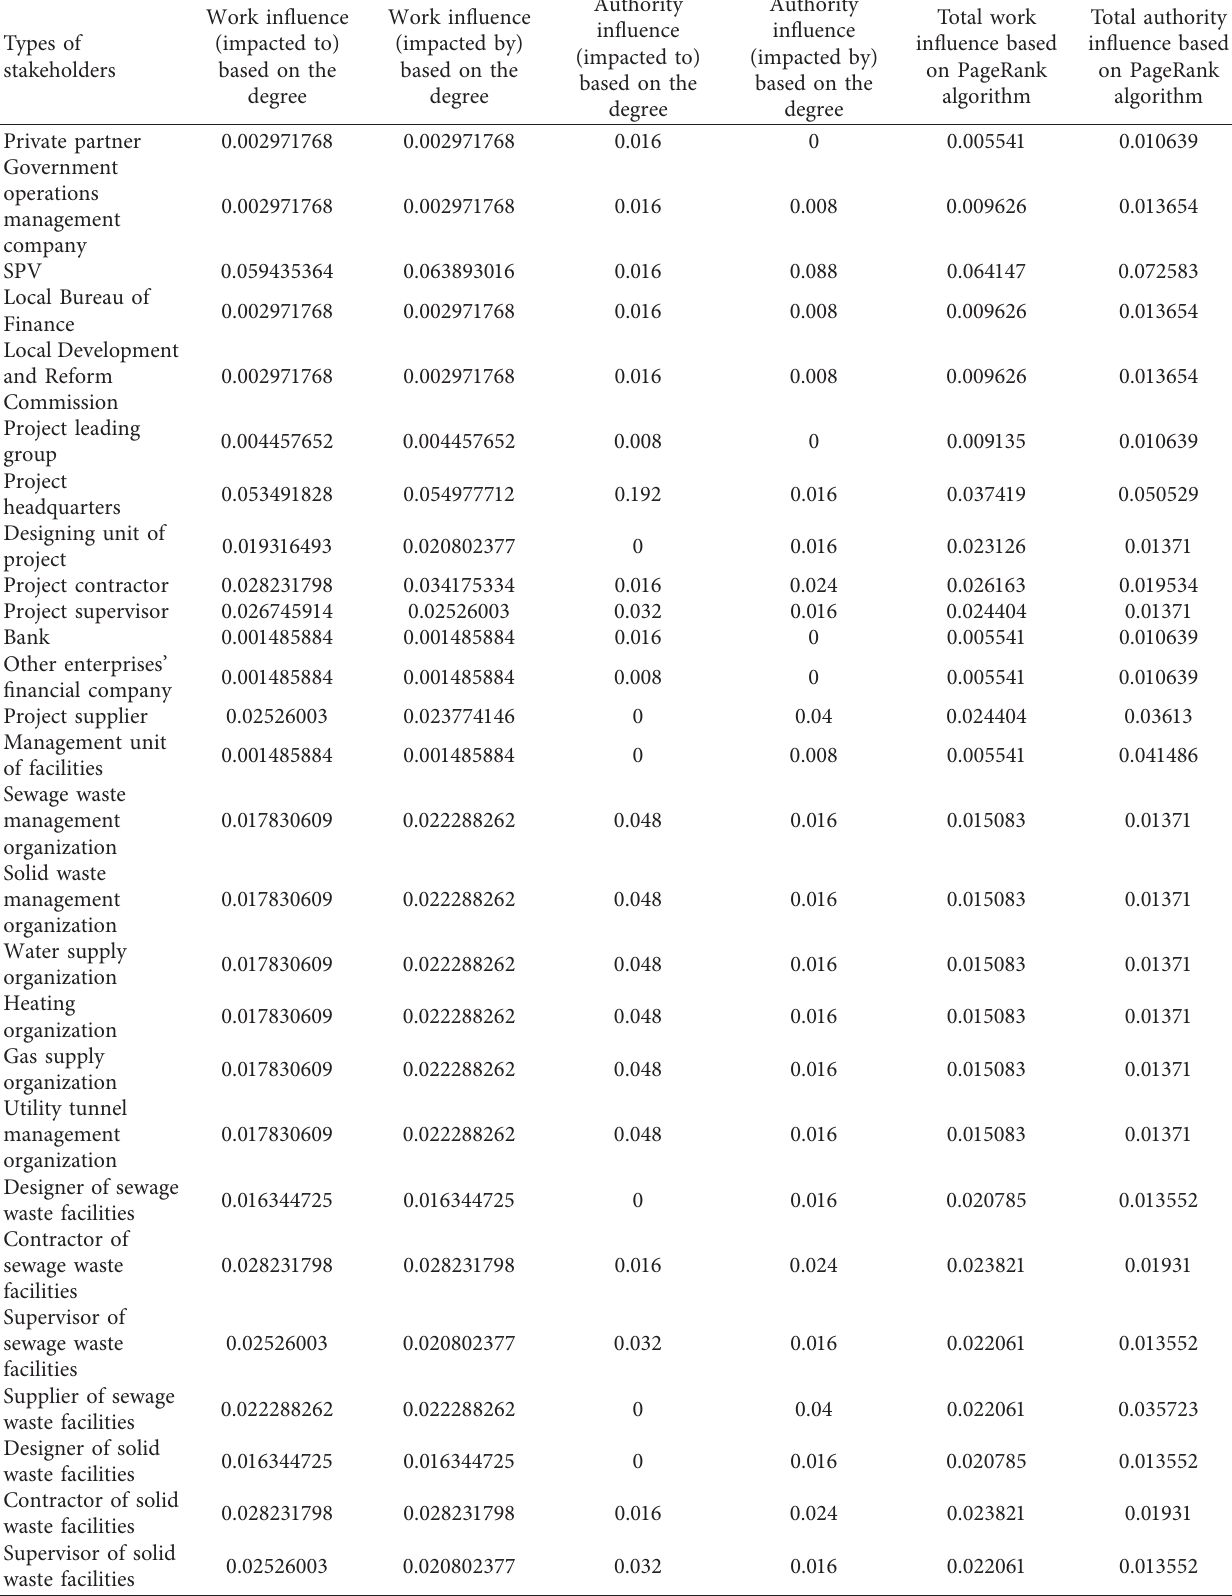
Table 3: The rank of influencing power on all